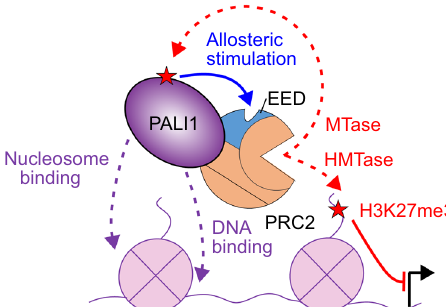
Fig. 9 A model for PALI1-mediated regulation of PRC2. PALI1 regulates PRC2 through two independent mechanisms: (i) PRC2 methylates PALI1 K1241 and possibly K1219, which then binds to the regulatory subunit EED to trigger an allosteric activation of PRC2. (ii) PALI1 facilitates DNA binding and nucleosome substrate binding. PALI1 is in deep purple, EED in light blue and other PRC2 core subunits are in orange. Dashed red arrows represent methylation, with the red stars represent methyl-lysines. The blue arrow represents a positive regulation by an allosteric activation, the dashed purple arrow represents DNA and nucleosome binding and the continues red line represents a transcriptional